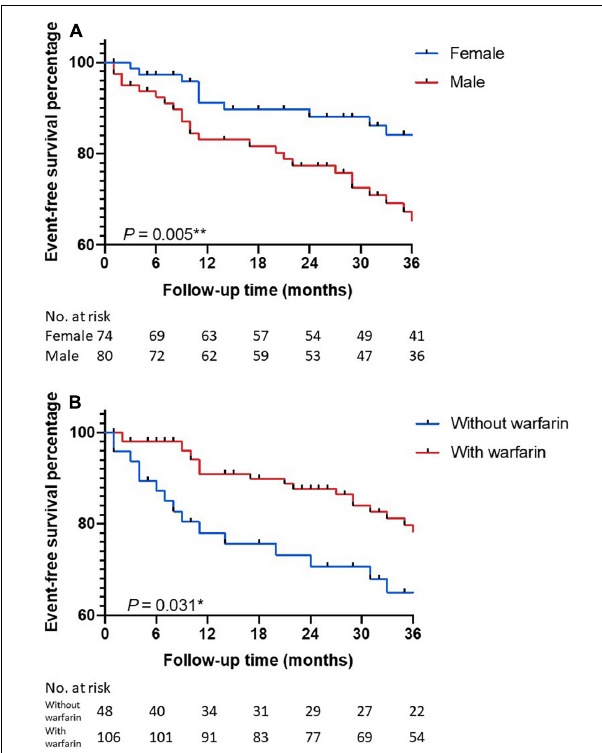
FIGURE 2 | The Kaplan–Meier curves for event-free survival. Groups were defined by (A) gender and (B) warfarin administration.